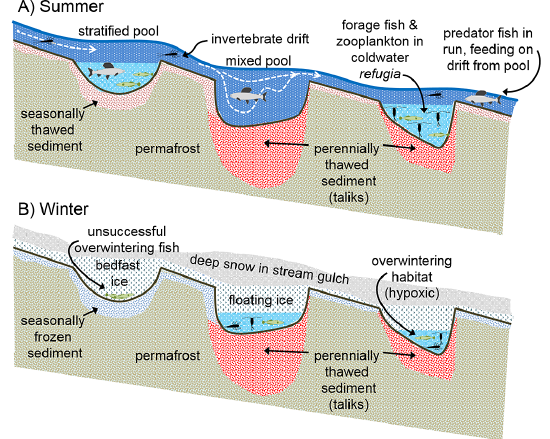
Figure 15. Conceptual diagram showing morphology, physical regimes, habitats, and organisms of a hypothetical pool-run system in the summer (a) and winter (b) based on observations and moni- toring studies in multiple beaded stream systems during these time periods over many